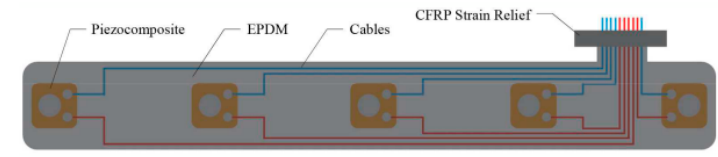
Figure 2. Integrated layer.